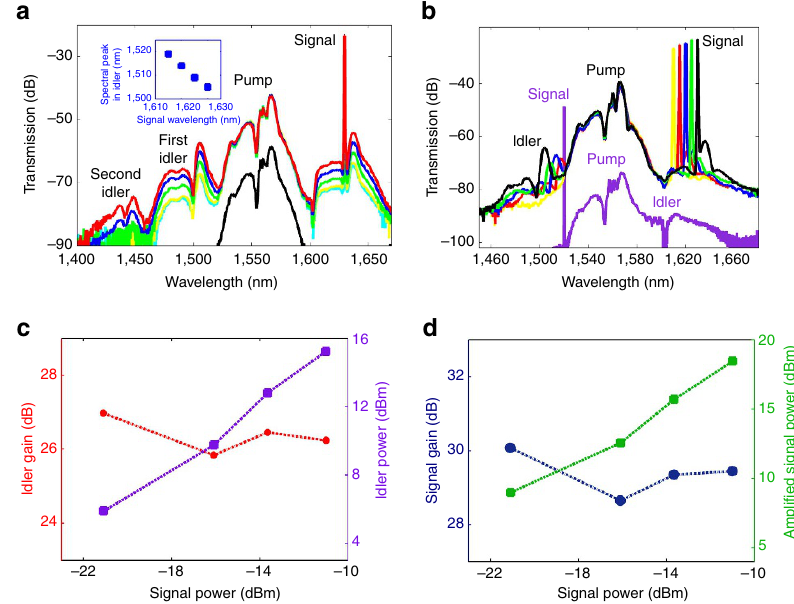
Figure 6 | Optical parametric amplification and cascaded four-wave mixing using a 2.0 ps pump. ( a ) Transmission spectrum as a function of signal power. The power of the generated idler scales linearly with the signal power. The spectral feature at 1,400–1,450nm represents evidence of cascaded four-wave mixing. The black solid curve represents the pump spectrum offset by (cid:3) 15dB, without the signal turned on. Coloured lines represent the measured spectra with a signal power of (cid:3) 21.1 (cyan), (cid:3) 16.1 (yellow), (cid:3) 13.7 (green) and (cid:3) 11.0dBm (blue). The inset shows the location of the spectral peak in the first idler as a function of signal wavelength. ( b ) Measured four-wave-mixing spectra as the signal wavelength is tuned from 1610 to 1,630nm, and 1,520nm. Solid lines denote the measured spectra for a signal located at 1,610 (yellow), 1,615 (red), 1,620 (blue), 1,625 (green) and 1,630nm (black). The spectrum for a signal at 1,520nm is offset by (cid:3) 30dB for clarity. ( c ) Measured idler gain (red circles) and power (purple squares) as a function of signal power at the waveguide output when the pump is off. ( d ) Measured amplified signal gain (blue circles) and power (green squares) as a function of signal power at the waveguide output when the pump is off. Dotted lines in c , d are a guide to the